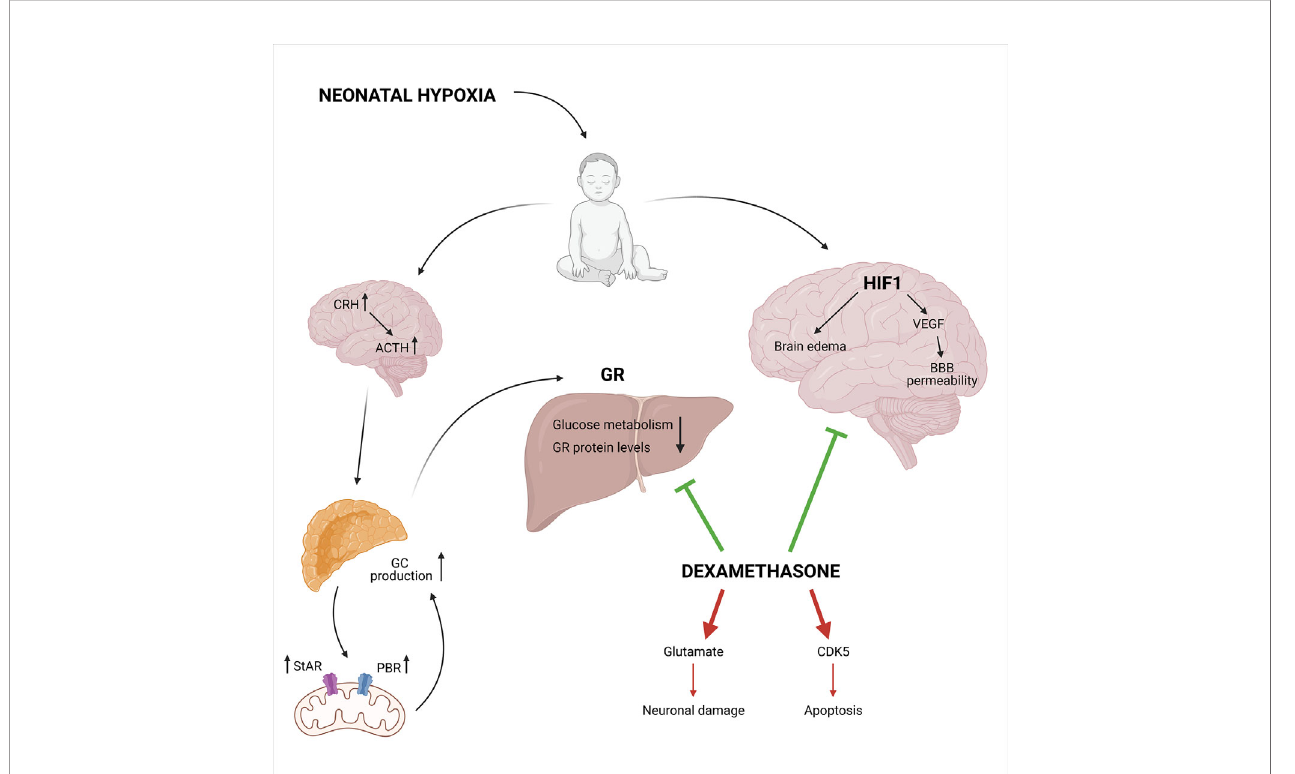
FIGURE 8 | The neuroprotective and neurotoxic effects of synthetic GCs during neonatal hypoxia. Neonatal hypoxia activates the HPA axis leading to increased GC production, partly mediated by a higher StAR and PBR expression involved in the mitochondrial cholesterol transport. This leads to decreased GR protein levels and reduced glucose metabolism. On the other hand, HIF1 is involved in the hypoxia-ischemia induced brain injury via the induction of VEGF and increases blood-brain barrier permeability in combination with brain edema. Neuroprotective effects can be induced by DEX via the inhibition of HIF1 mediated brain injury and the inhibition of the GR mediated effects in the liver. Next to the neuroprotective effects, DEX also has neurotoxic effects. It can lead to increased glutamate levels and CDK5 expression causing neuronal damage and apoptosis, respectively. Figures created with